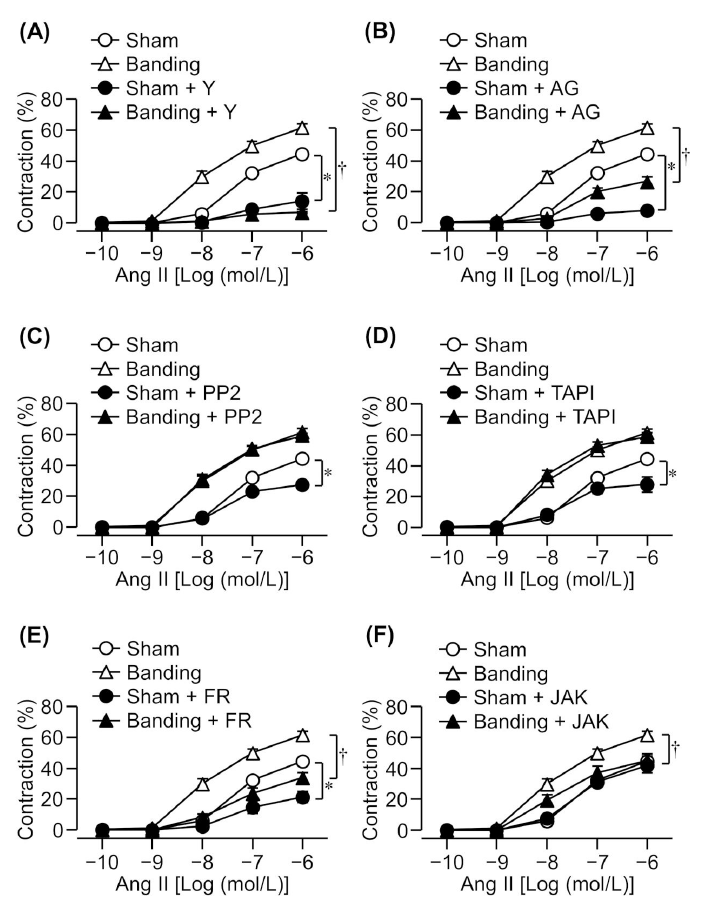
Figure 1. Effects of various inhibitors on angiotensin II (Ang II)-induced contraction in sham-operated (Sham) or pressure-overloaded (Banding) rat thoracic aortic rings. ( A ): Y-27632 (Y: 10 µ mol/L); ( B ): AG1478 (AG: 10 µ mol/L); ( C ): PP2 (3 µ mol/L); ( D ): TAPI-0 (TAPI: 10 µ mol/L); ( E ): FR180204 (FR: 10 µ mol/L); and ( F ): JAK2 inhibitor II (JAK: 10 µ mol/L) was added 15 min before Ang II